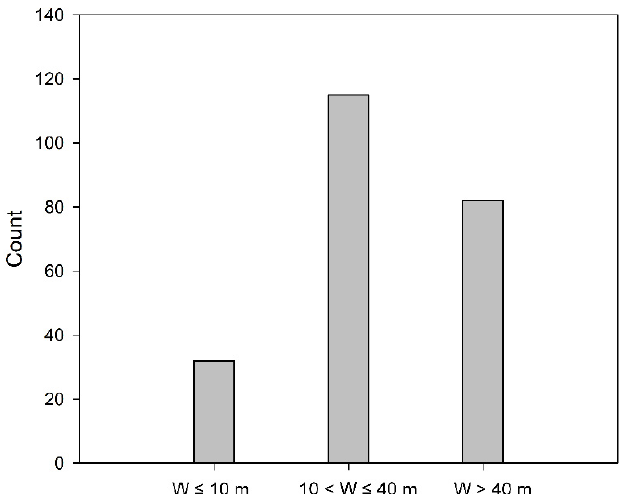
Figure 1. Frequency distribution of channel width in the data utilized to derive the predictive formulae of the longitudinal dispersion coefficient (Table S1).